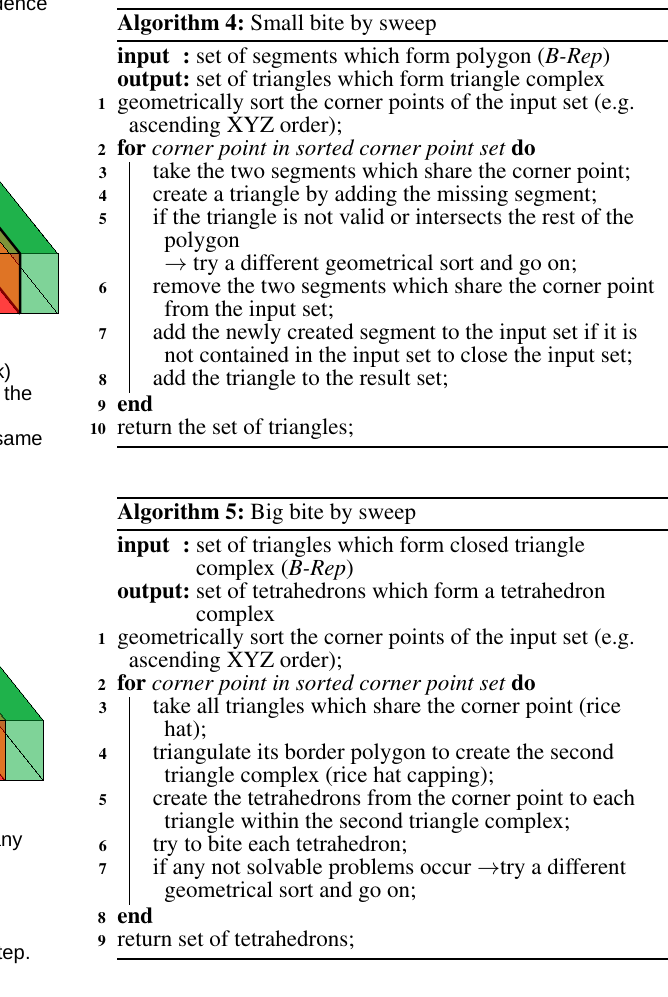
Figure 5. Six 2 -dimensional simplicial complexes triangulated to one 3 -dimensional simplicial complex